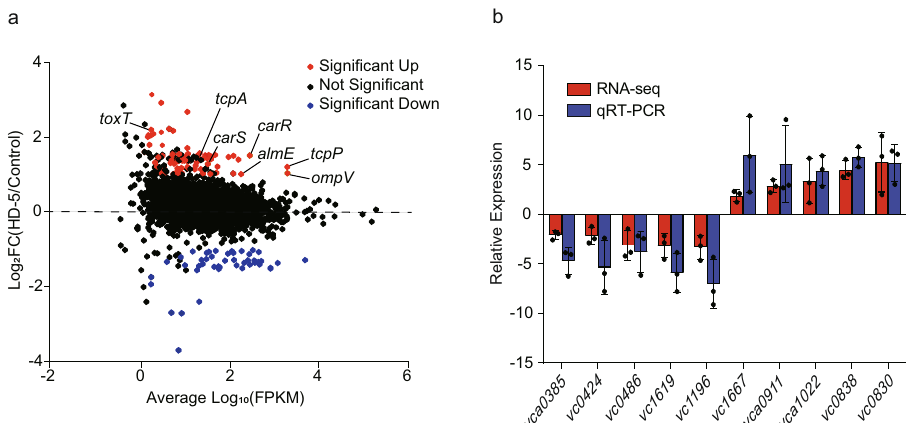
Fig. 1 Transcriptome analysis of V. cholerae in response to HD-5. a MA plot of differential gene expression levels in V. cholerae EL2382 in AKI medium containing 0 and 50 μ g/mL HD-5. Each dot represents a single gene. Red dots represent genes whose abundance is signi fi cantly upregulated, blue dots downregulated, and black dots unchanged (or non-signi fi cantly changed) regulation. b RNA-seq results validation by qRT-PCR. Data are presented as mean ± SD ( n =